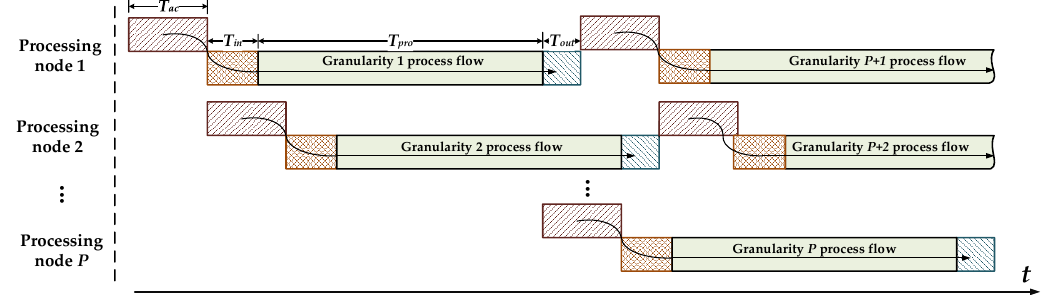
Figure 9. The time-sequence of multi-node processing parallel processing.